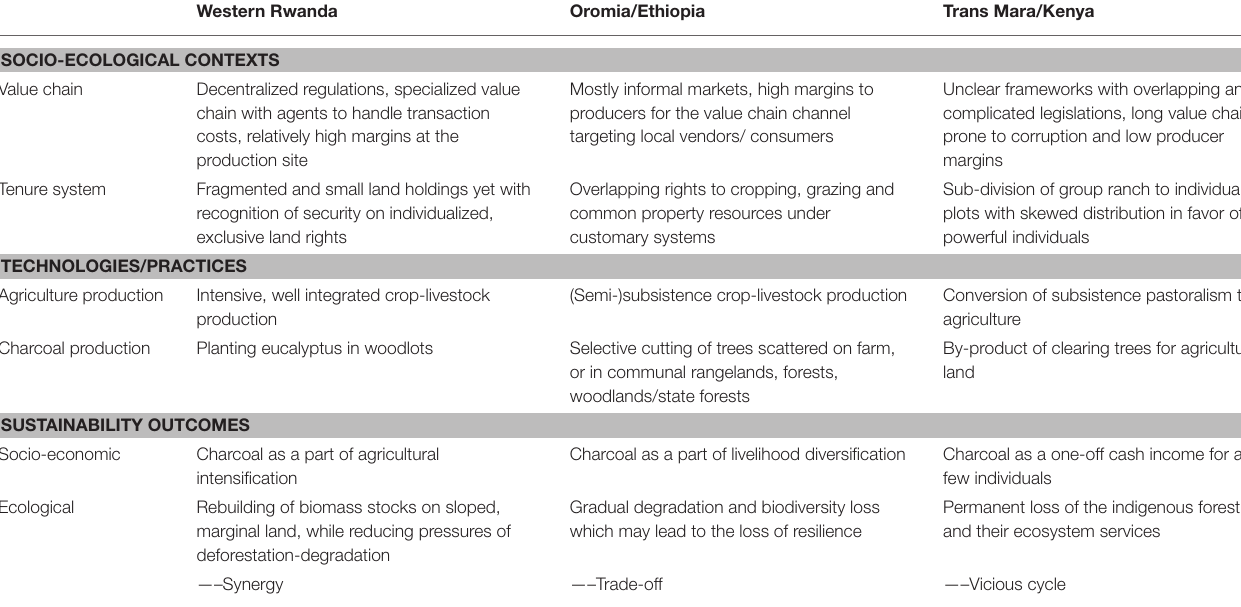
TABLE 1 | Comparison of socio-ecological contexts, technologies/practices adopted, and sustainability outcomes of the three case